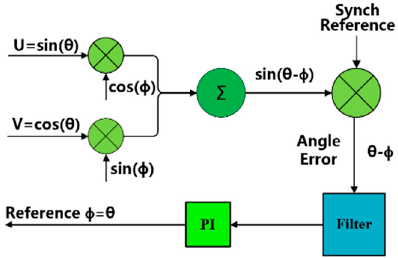
Figure 2. Block diagram of angle demodulation.